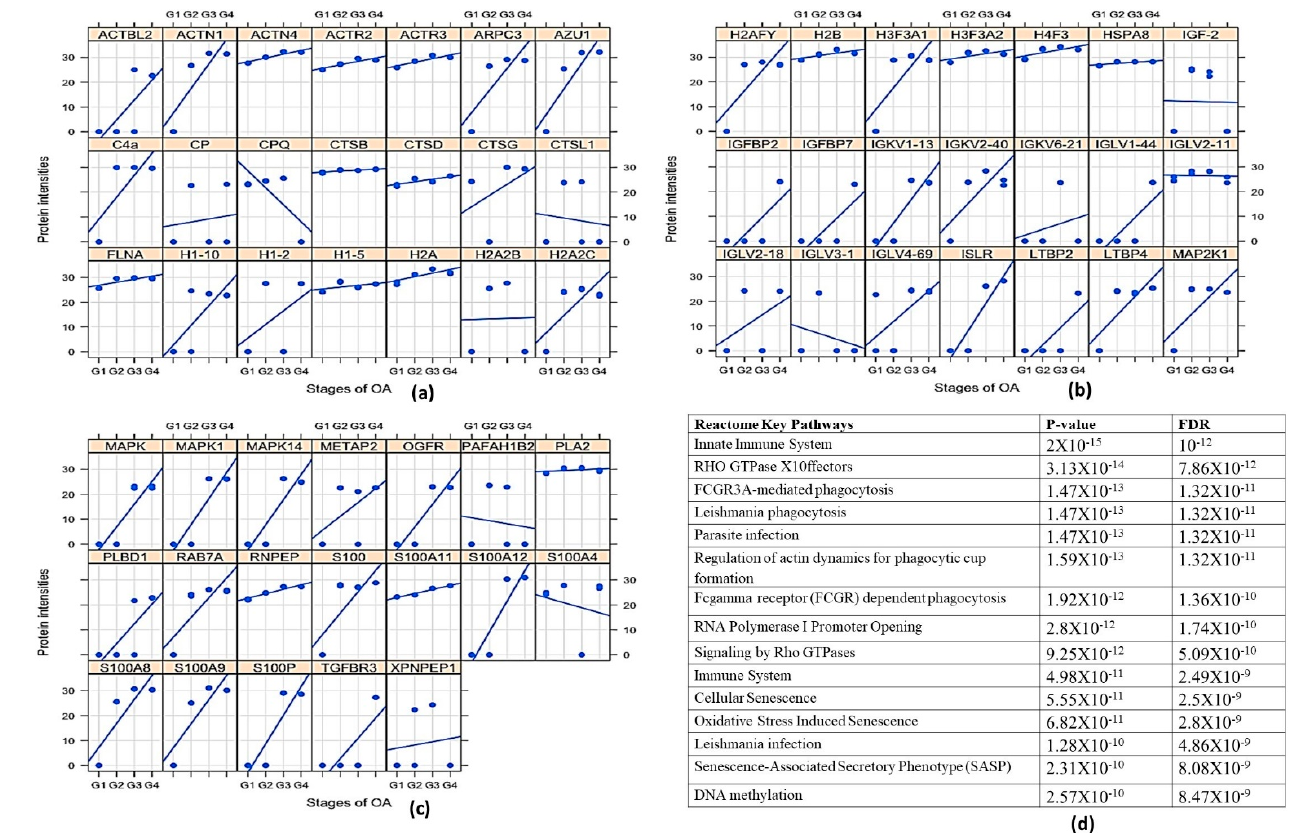
Figure 6. Proteomics analysis of OA SF. For the proteomics analysis, four patients of each grade (4 × 4 = 16) were analysed through MS/MS. ( a – c ) represents a grade-wise picture (lattice plots) of dif- ferent protein subsets that were differentially expressed in OA SFs; differential protein expressions were determined by comparing the fold change of each protein found in KL grade I SFs. In total, 799 proteins were found differentially expressed. These proteins contain mast cell regulatory factors such as light chain immunoglobulins, S100 A12, histones, actins, mitogen-activated protein kinase (MAPK) family and mast cells degranulation proteases such as carboxypeptidase and cathepsins.